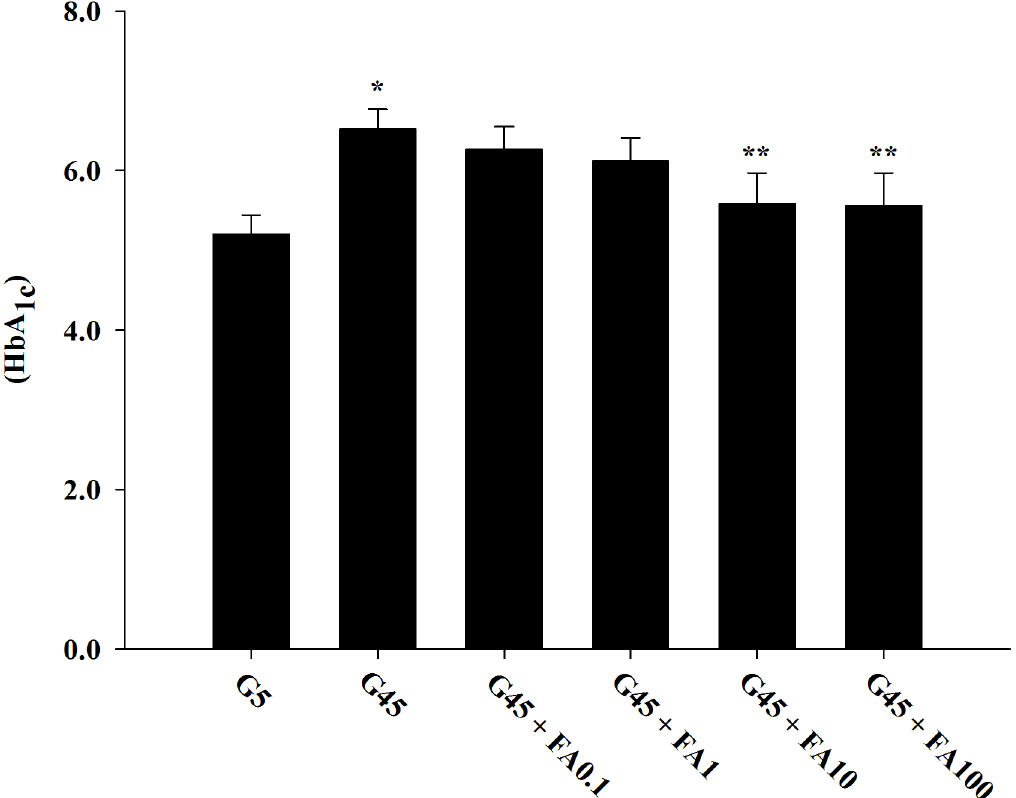
Fig 2. The effects of ferulic acid (0.1 – 100 μ M) on protein glycation (glycated hemoglobin or HbA 1c ) in erythrocytes treated with 45 mM glucose. The results are expressed as mean ± SEM ( n = 6). * p < 0.05 compared to 5 mM glucose (G5) and ** p < 0.05 compared to 45 mM glucose (G45) treatments.